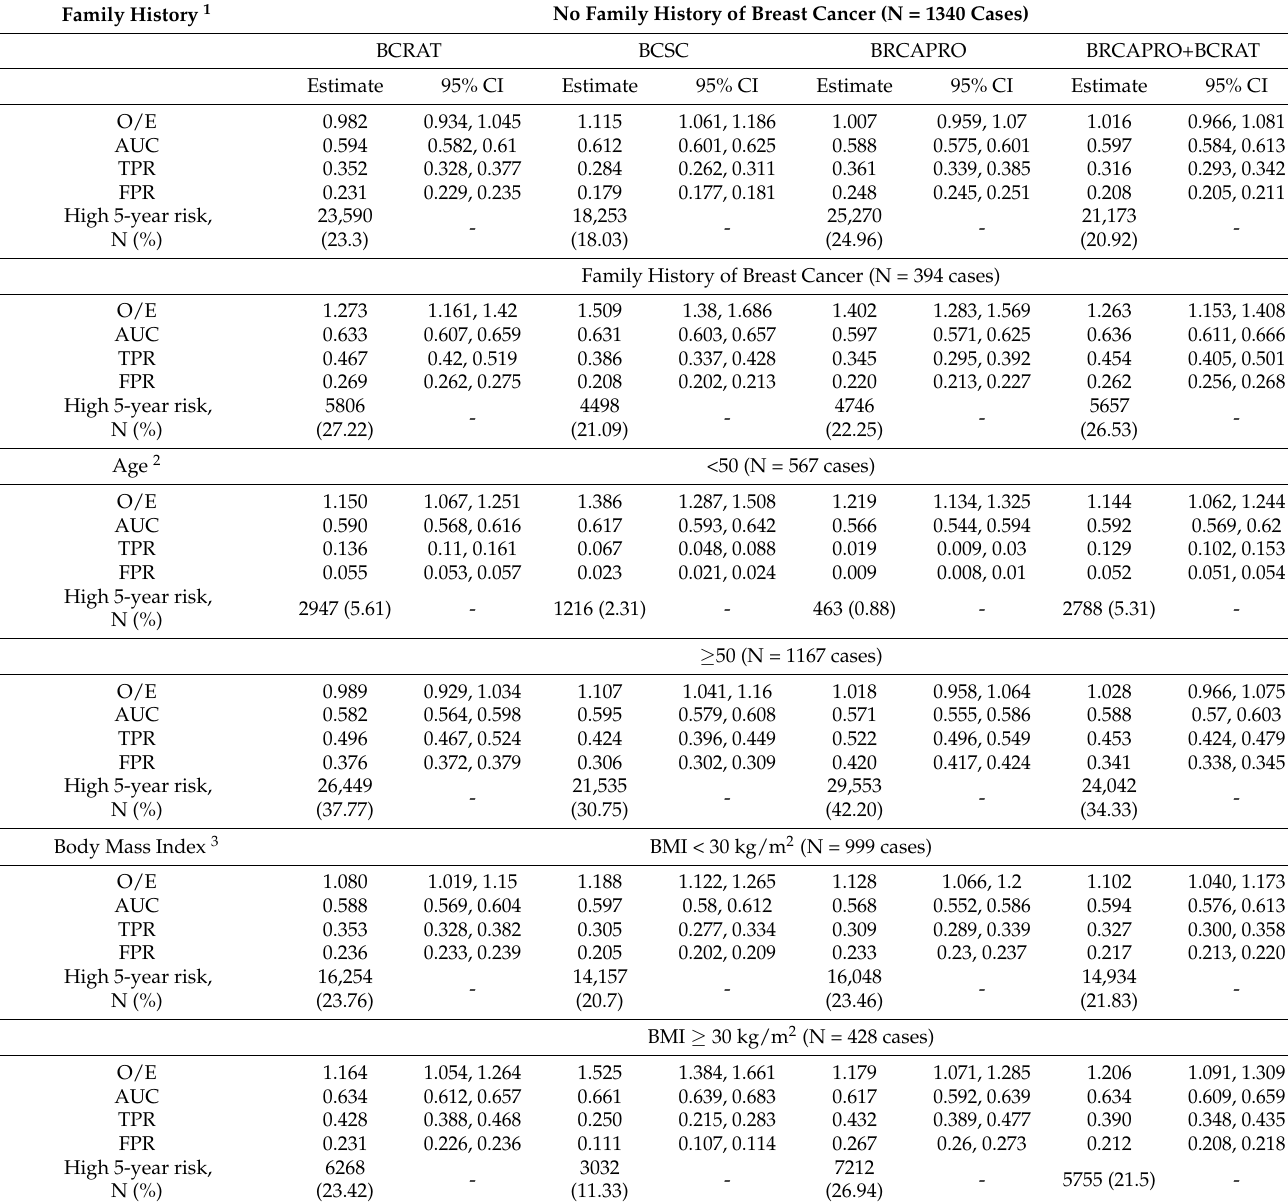
Table 5. Performance of risk models by family history of breast cancer, age, and